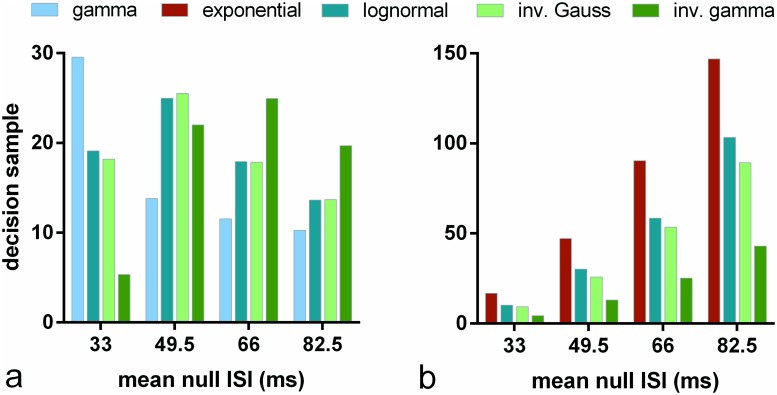
Decision sample in s-MSPRT against mean ISI for range of pdfs and parameter sets.Each bar shows, for the pdf indicated in the legend, the mean decision sample for N = 10 alternatives, averaged over 950 correct out of 1000 total trials. Panel a used parameter sets ΩIV, Ω^IV(49.5), Ω^IV(66), Ω^IV(82.5), panel b used ΩFV, Ω^FV(49.5), Ω^FV(66), Ω^FV(82.5) (see Methods). Each group of bars relates to one parameter set with its μ
0 indicated on the x − axis (ΩIV, ΩFV have μ
0 = 33). For the case of ΩFV and any Ω^FV(μ0), the gamma and exponential distributions are identical and so not reported separately.